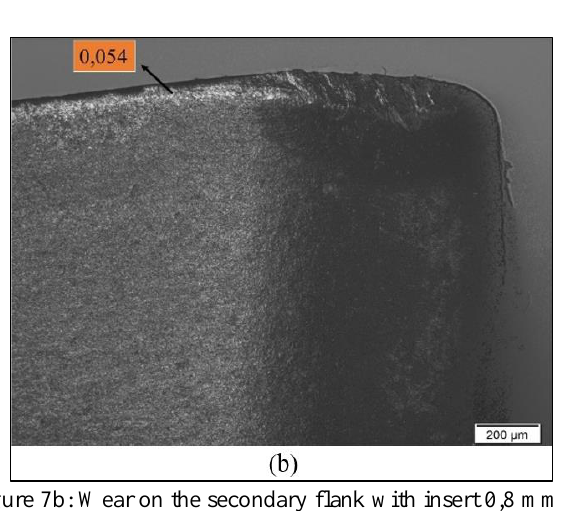
Figure 7b: Wear on the secondary flank with insert 0,8 mm: b) With sealant. Source: Authors, (2022).